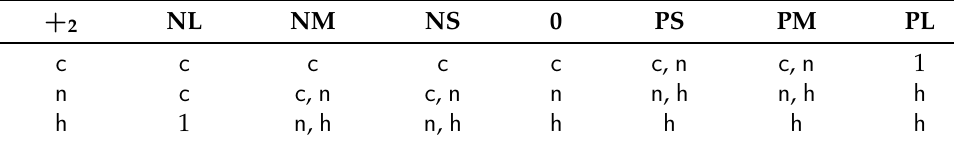
Table 3. Composition of components of L 6